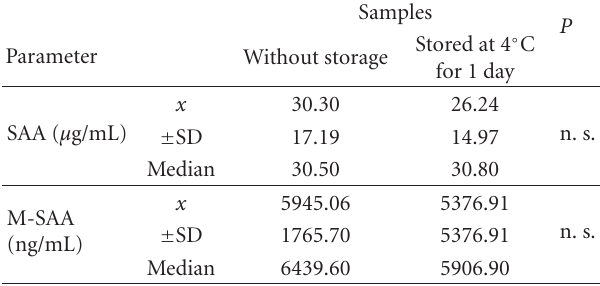
Table 2: Comparison of the concentrations of SAA and M-SAA analyzed in samples without storage and in samples stored at 4 ◦ C for 1 day.